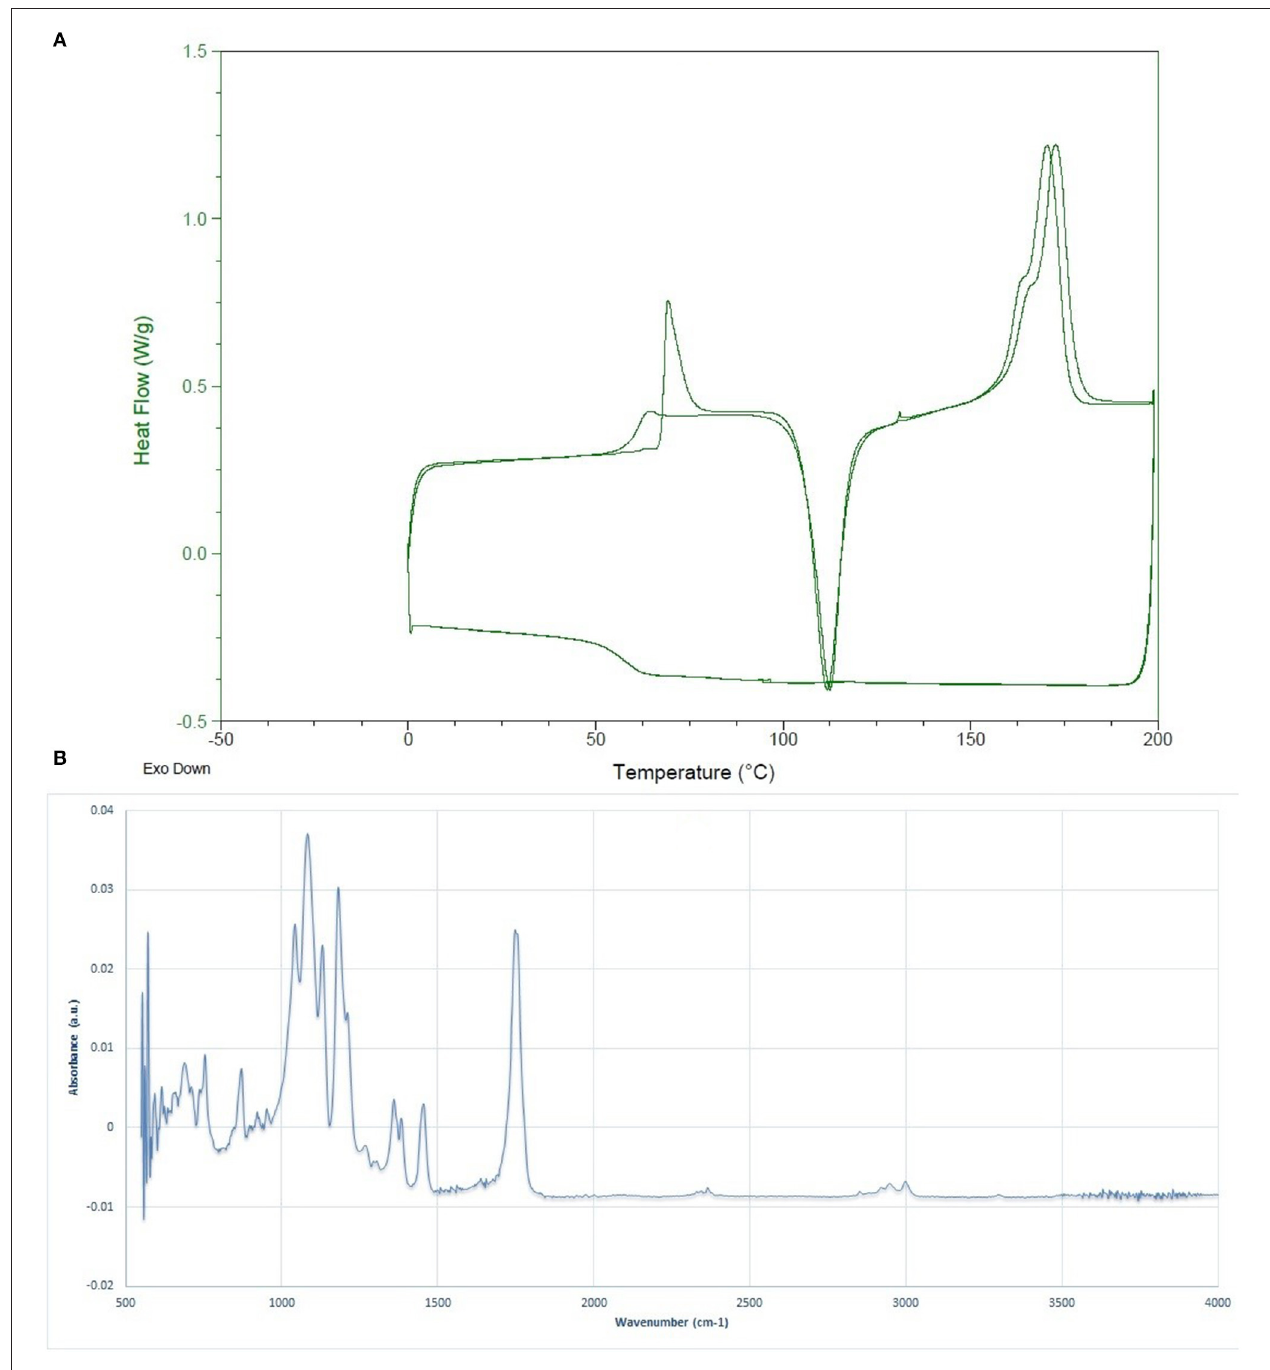
FIGURE 2 | (A) DSC curve, and (B) FTIR spectrum of the synthesized poly (L-lactic acid) (PLLA).